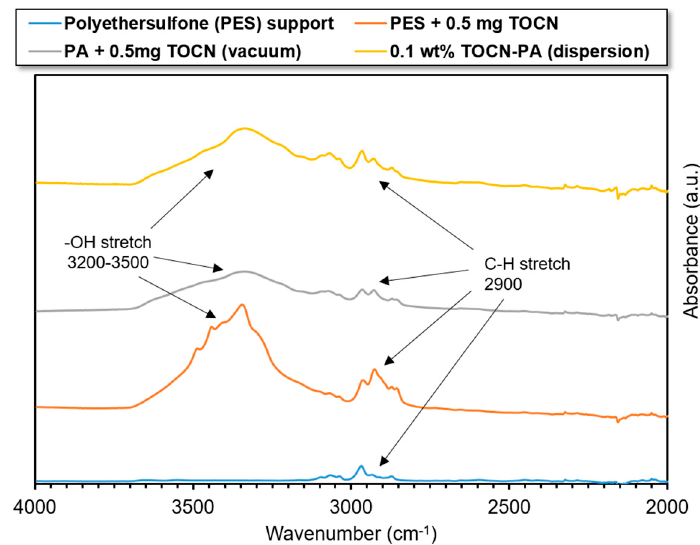
Figure 5. FT-IR scans (wavenumbers 2000–4000 cm − 1 ) of PES support material, PES with 0.5 mg TOCNs deposited, TFN polyamide membrane with 0.5 mg TOCN loading (vacuum filtration fabrication), and 0.1 wt% TOCN TFN membrane (dispersion fabrication method).